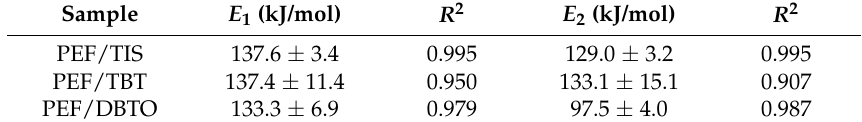
Table 3. Activation energies along with their standard errors and correlation coefficients of the transesterification and esterification reaction of PEF prepared by TIS, TBT, and DBTO catalysts.